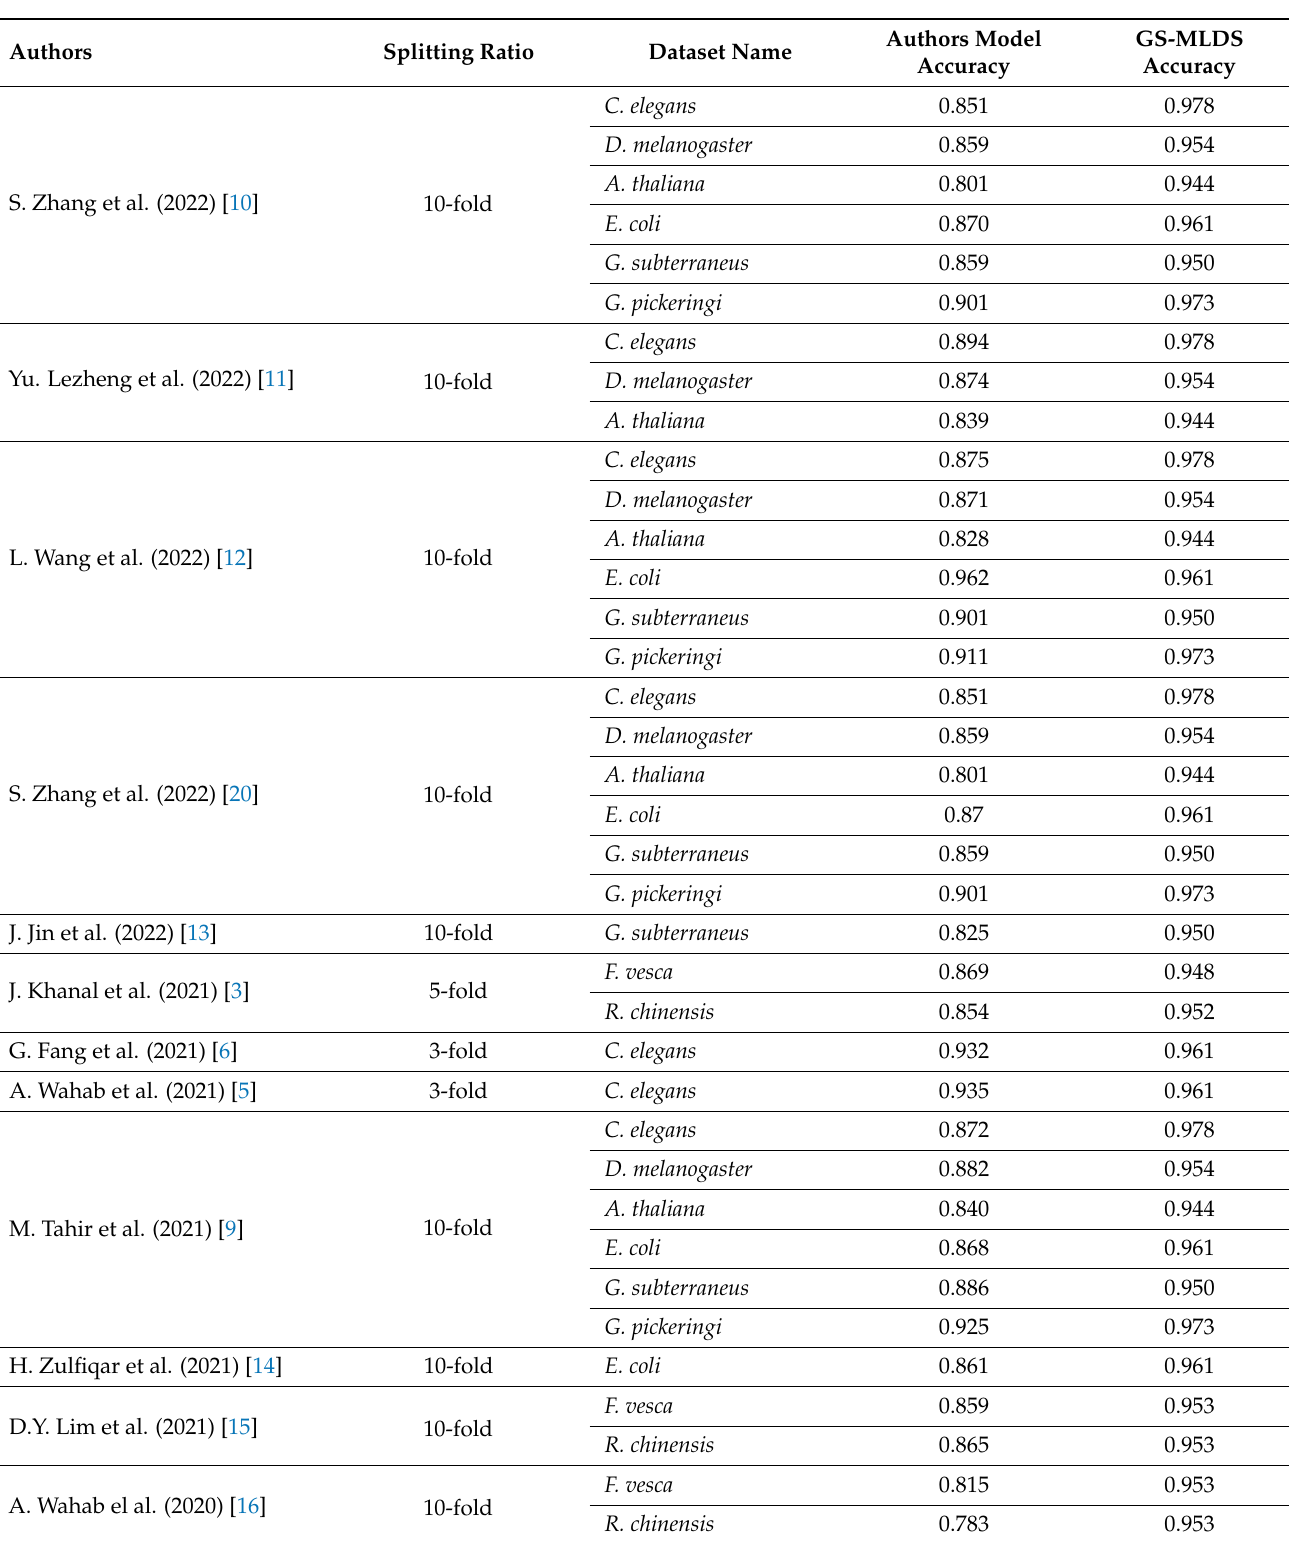
Table 8. Comparison of GS-MLDS with another author’s model utilizing their